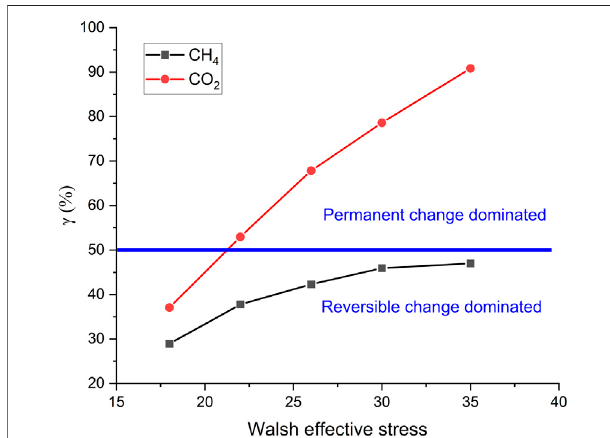
FIGURE 9 | γ for CH 4 and CO 2 obtained from Figure 7 using Eq. 5 , plotted as a function of Walsh effective stress, illustrating that sorption- induced reversible effect dominated the changes occurring on fracture surfaces upon CH 4 adsorption, while the sorption-induced permanent effect dominated upon CO 2 adsorption when the Walsh effective stress is higher than 22